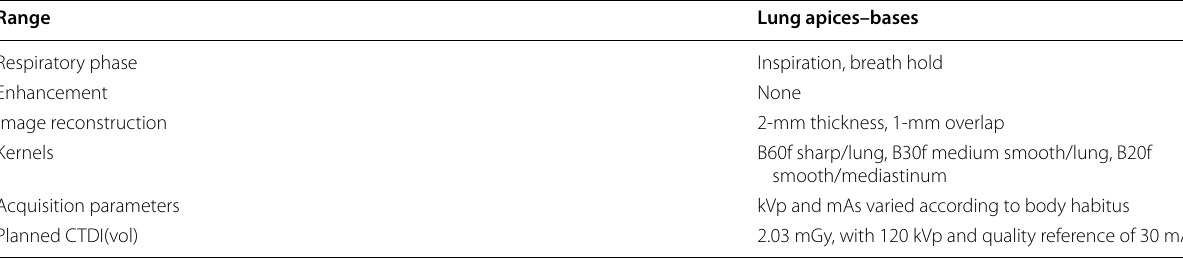
CT, computed tomography